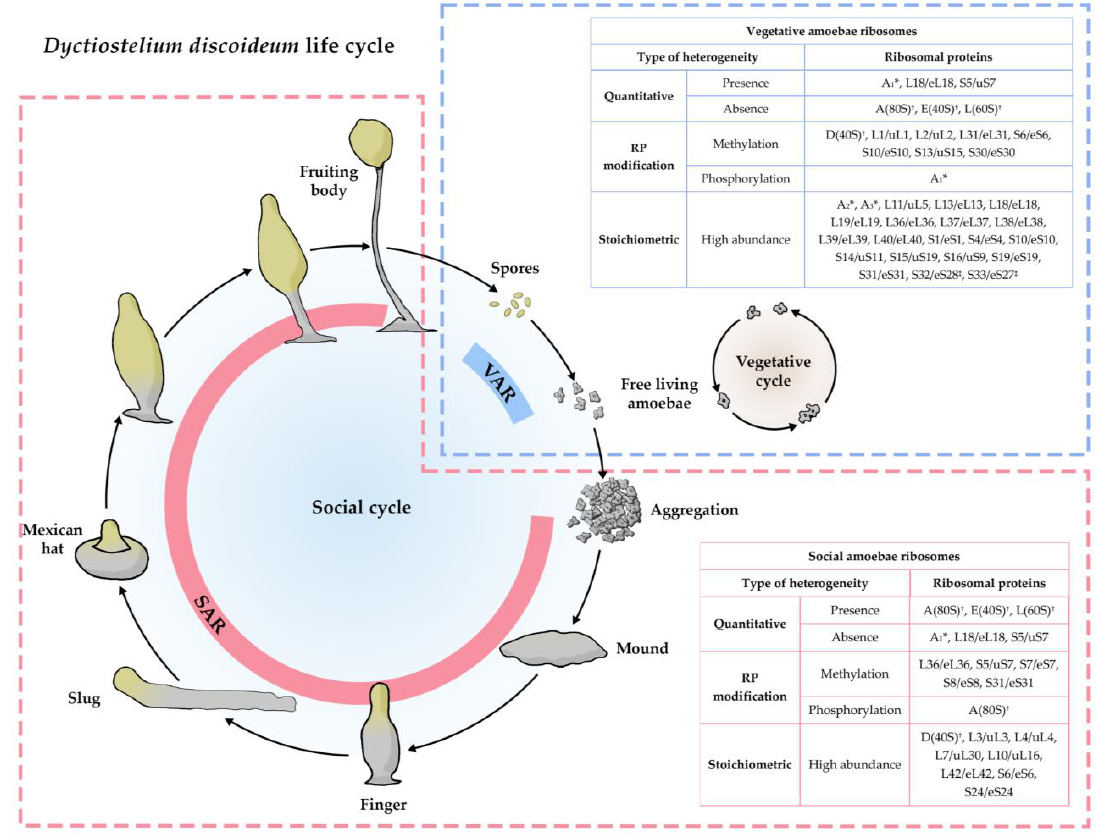
Figure 1. Ribosome switching in Dyctiostelium discoideum ’s life cycle. The vegetative cycle of D. discoideum (light blue dotted box) includes free-living amoebae that reproduce by binary fission when there are proper nutritional conditions; in this cycle, vegetative amoebae ribosomes (VAR) express the ribosomal proteins (RP) shown in the blue table. The social cycle (light red dotted box) starts when there are deficient nutritional conditions, forcing amoebae to aggregate and form a multicellular organism. Social amoebae ribosomes (SAR) express a different set of RPs and modification patterns, which are shown in the light red box. The correlation of the new nomenclature was conducted following the new system for naming ribosomal proteins [73]. * The correlation of these proteins with the current nomenclature is unknown. † These proteins are known to be associated with the respective ribosomal subunits, but no numerical designation was given by the authors [69].